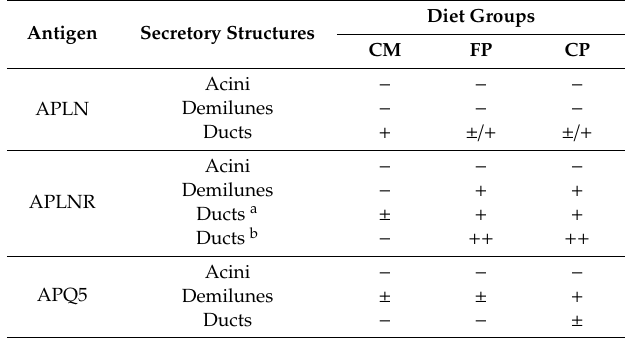
Table 1. Sample reaction intensity expressed in arbitrary units toward immunohistochemical